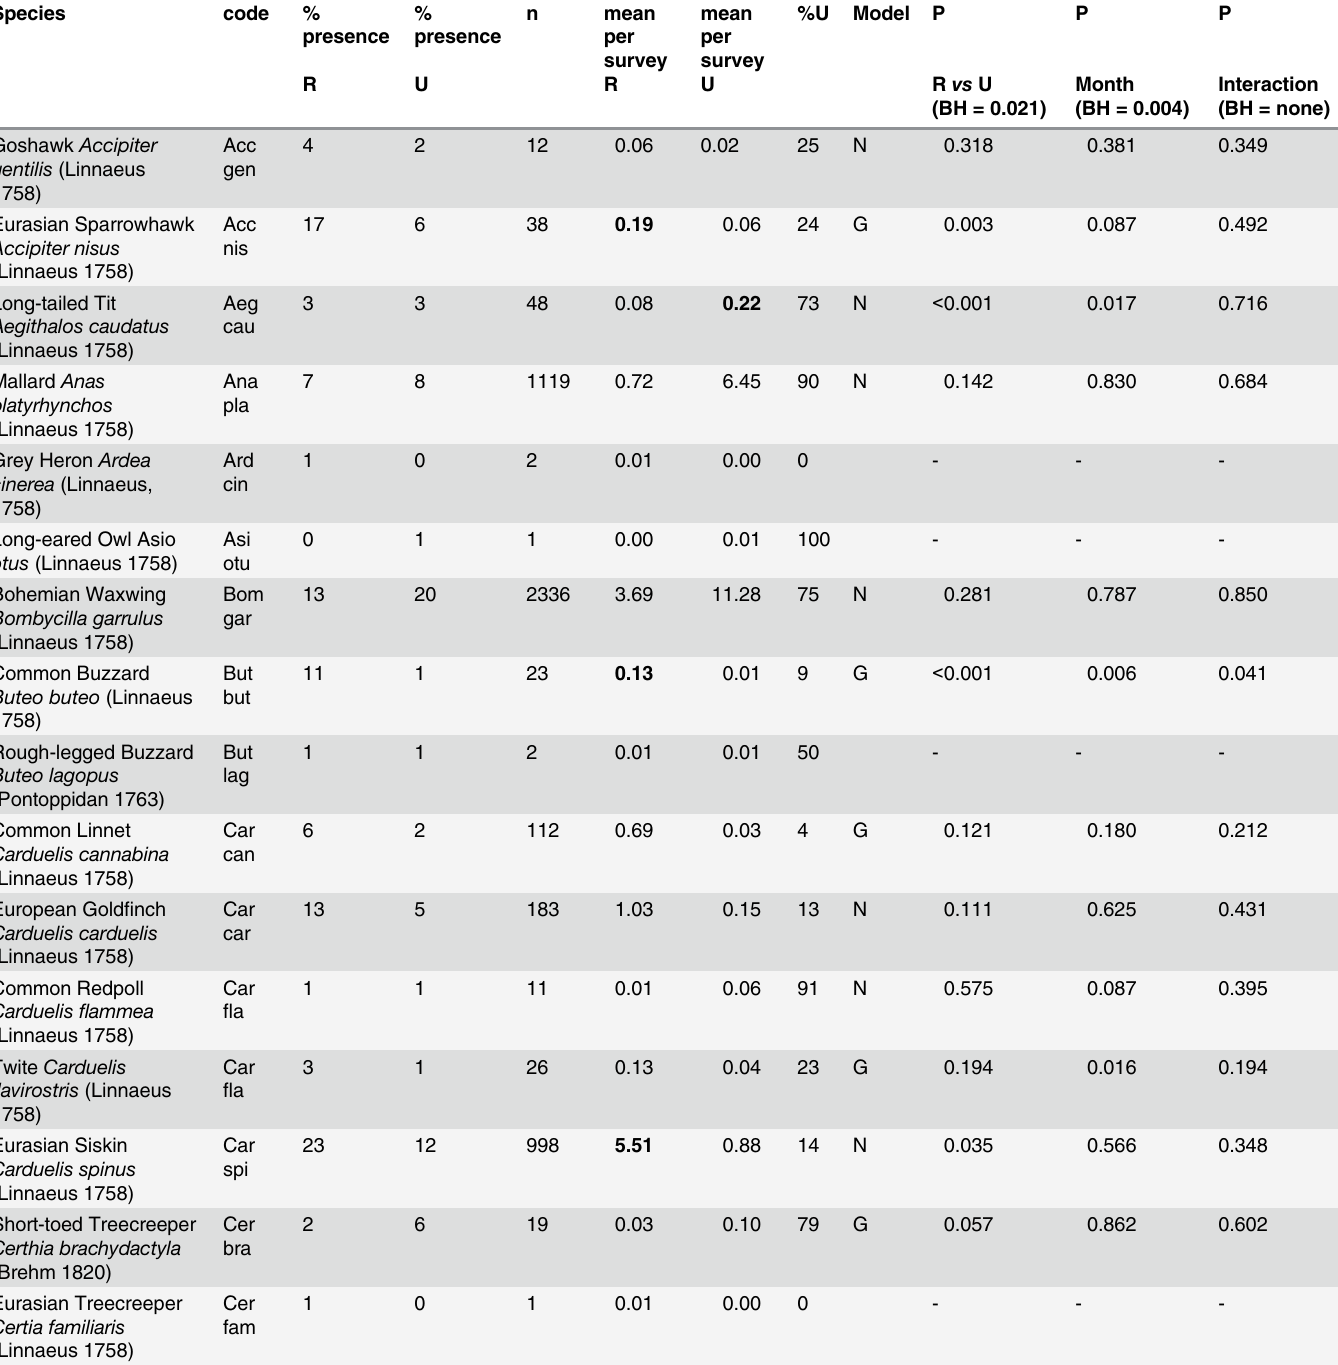
Table 4. The percentage of the 156 square/month combinations for both rural (R) and urban (U) areas in which each species (at least one individu- al) was recorded, the total number of individuals (n) recorded, the mean number for rural and urban areas, the percentage of records recorded from urban areas (%U), whether the model was based on negative binomial (N) or Gaussian (G) distribution, and the significance level of rural/ urban, month and interaction terms from GLMM (month means not shown to save